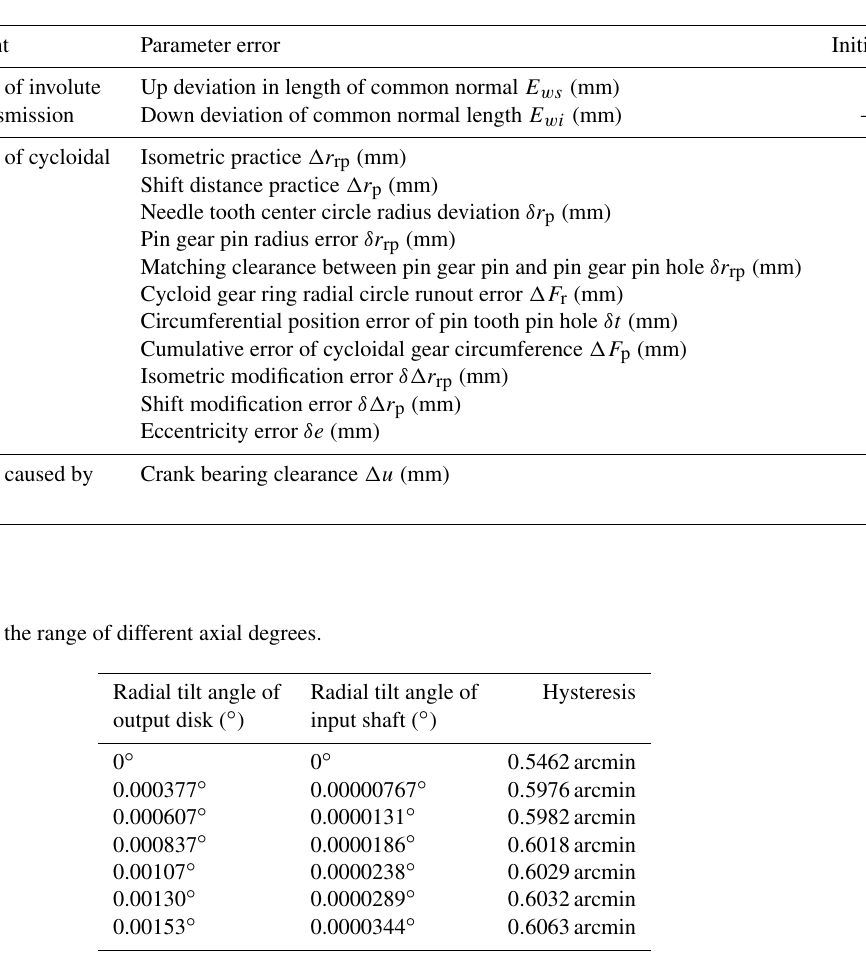
Table 9. The initial values of the parameter error corresponding to the difference components.